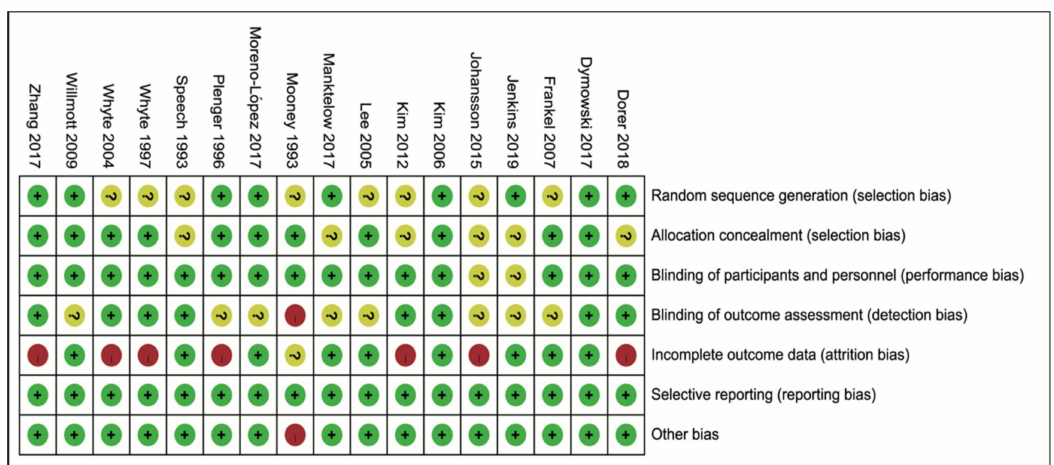
Figure 2. The detail risk of bias of included studies was assessed according to the Cochrane